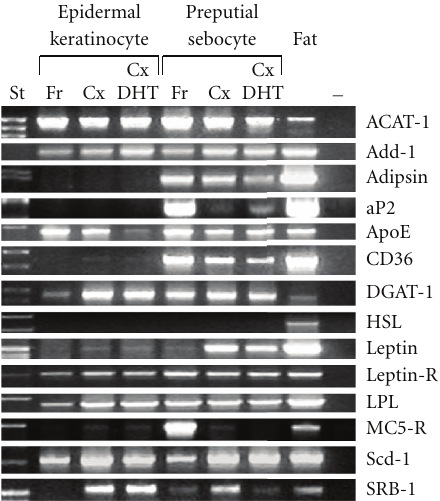
Figure 4: Comparison of the expression of lipogenic regulatory genes in freshly dispersed (Fr) and cultured (Cx) ± dihydrotestos- terone (DHT) preputial sebocytes and epidermal cells, using RT- PCR. Total RNA was isolated from adult rat preputial sebocytes, epidermal cells and homogenized epididymal fat pad. Primers specific for the listed genes were used (see Table 1). Adipsin, aP2, CD36, and MC5-R were only detected in sebocytes, not in fresh or cultured epidermal cells. Leptin was detected in cultured sebocytes (less mature) to a greater extent than in freshly dispersed sebocytes (more mature) or epidermal cells. MC5-R was detected in freshly dispersed sebocytes to a greater extent than cultured sebocytes.